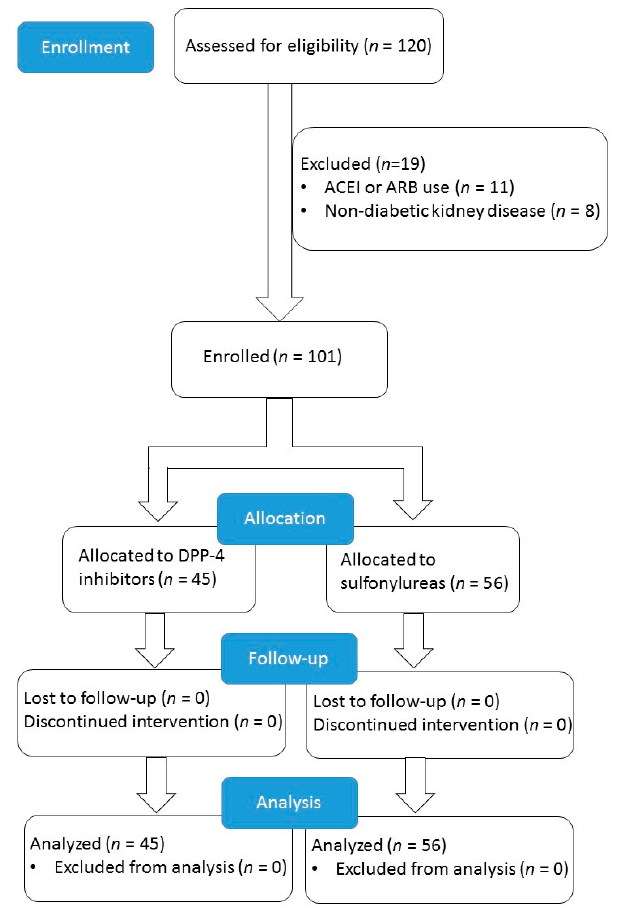
Figure 1. Enrollment protocol of the study. ACEI: angiotensin-converting enzyme inhibitors, ARB: angiotensin receptor blockers.